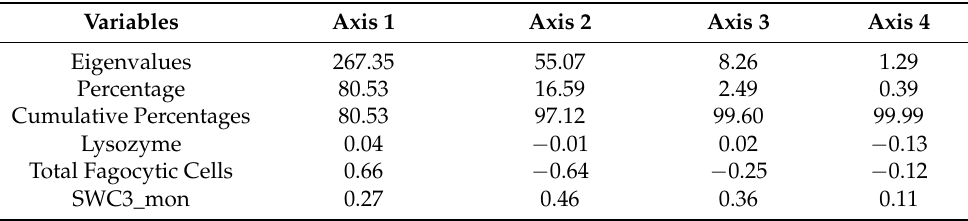
Table 6. Results of PCA based on the average level of blood factors of the control and experimental groups differing in the presence of glutamine in the diet. Values in bold are statistically significant for p <